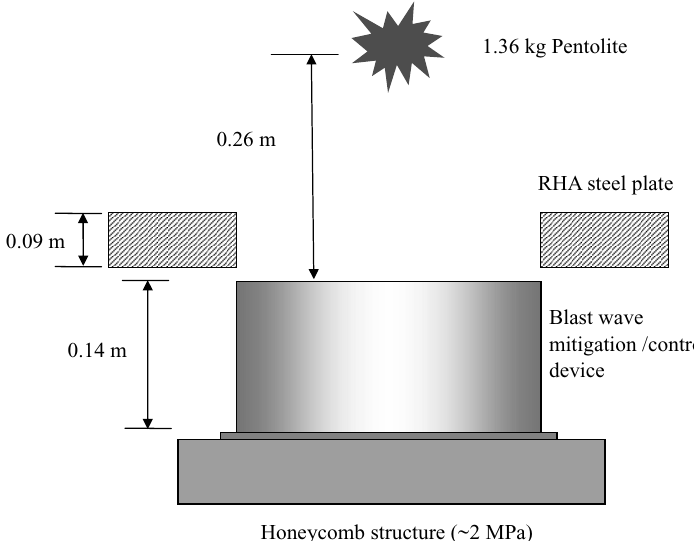
Fig. 3. Schematic of the first experimental setup for the explosive charge test.